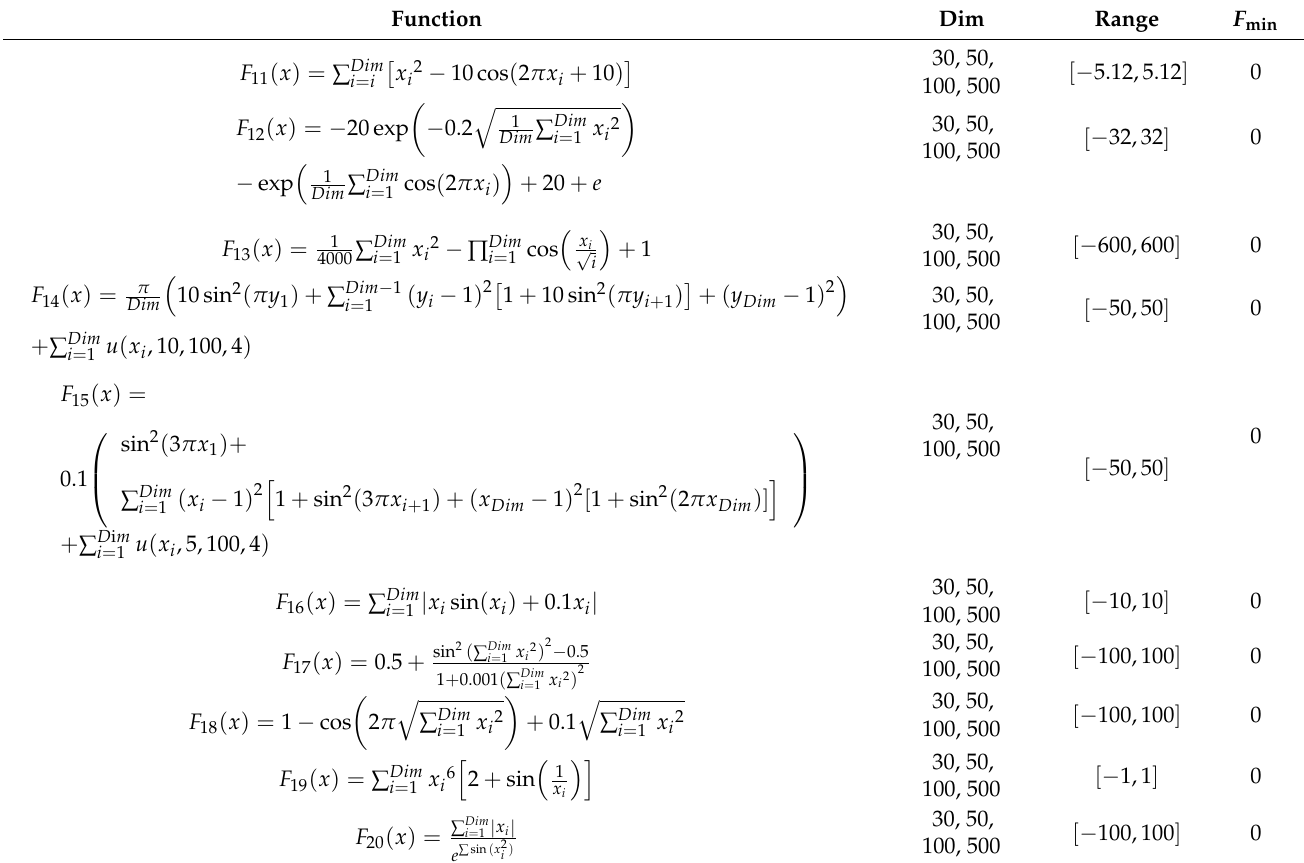
Table 2. Multimodal benchmark functions.